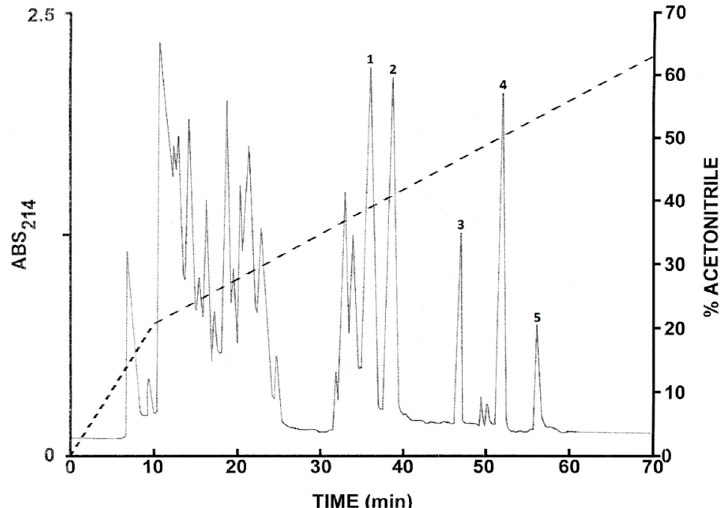
Figure 1. Elution profile on a semipreparative Vydac C-18 column of pooled skin secretions from nine Leptodactylus insularum frogs after prior concentration on Sep-Pak cartridges. The dashed line shows the concentration of acetonitrile in the eluting solvent. Peaks 1–5 contain ocellatin-related peptides that were purified to near homogeneity by further chromatography on Vydac C-8 and dimethylphenyl columns. Absorbance was monitored at 214 nm and fractions (1 min) were collected.